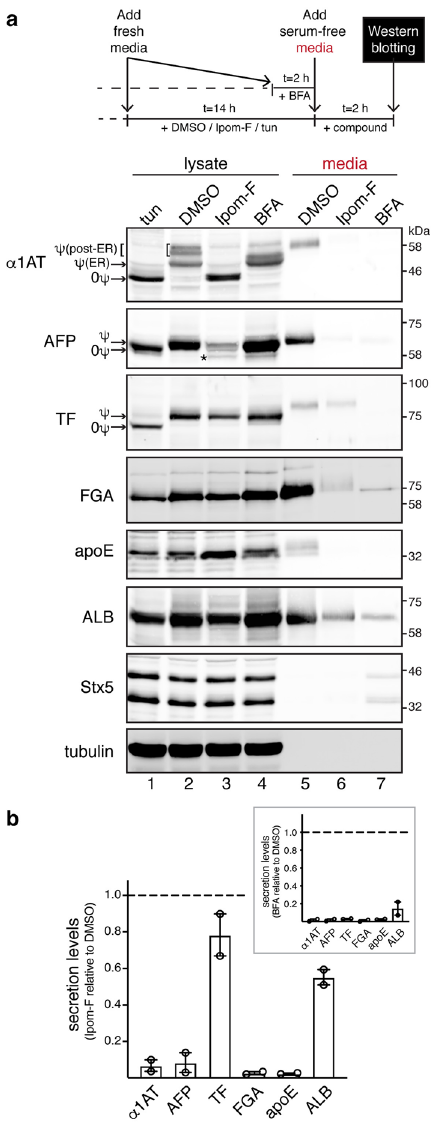
Figure 2. Ipom-F inhibits protein secretion in a substrate-selective manner. ( a ) HepG2 cells were pre-treated either with DMSO, Ipom-F (100 nM) or tunicamycin (tun; 5 μg/ml) for 14 h or with BFA (2.5 μg/ml) for 2 h, followed by treatment in serum-free media for another 2 h in the presence of the compounds as shown in the schematic representation of the assay. Equal amounts of total protein from clarified cell lysates and serum- free media were analysed by immunoblotting for the indicated endogenous secretory proteins or the SNARE syntaxin-5 (Stx5). For the analysis of FGA, 2.5× more of the media sample than lysate sample was loaded to increase FGA signal sensitivity in the media. Tunicamycin treatment effectively prevented N-glycosylation (indicated by ψ) to yield non-glycosylated (0ψ) species. Endogenous α1AT can be observed as three protein bands. The upper bands represent the mature, post-ER forms of α1AT that contain complex N-glycans (reflected by heterogeneity in electrophoretic mobility), while the lower band corresponds to the immature, core-glycosylated form of α1AT located in the ER. The asterisk indicates a truncated form of AFP, previously described in HepG2 70 and perinatal rat liver 71 cells, which becomes more prominent after treatment with stress- inducing compounds (see also Fig. 3a). Endogenous Stx5 exists as two isoforms, a 42 kDa-ER and a 35 kDa- Golgi isoform, that result from an alternative initiation of translation 72 . Note that the low levels of Stx5 recovered in media from BFA-treated cells may have been associated with BFA-induced loss of cell integrity. However, no signal from the abundant cytosolic tubulin was detected in these media, suggesting that the release of Stx5 in the media was most likely through unconventional secretion mechanism(s). Representative immunoblots are shown (full-length blots presented in Supplementary Fig. S6). ( b ) Quantification of protein levels in the media harvested from cells treated with Ipom-F or BFA (inset) as shown in ( a ). Secretion levels represent ratios of the protein signal in the media fraction to the corresponding signal in cell lysates (normalised against tubulin). Secretion levels were set to one in DMSO-treated cells. Values are mean ± s.e.m from two independent